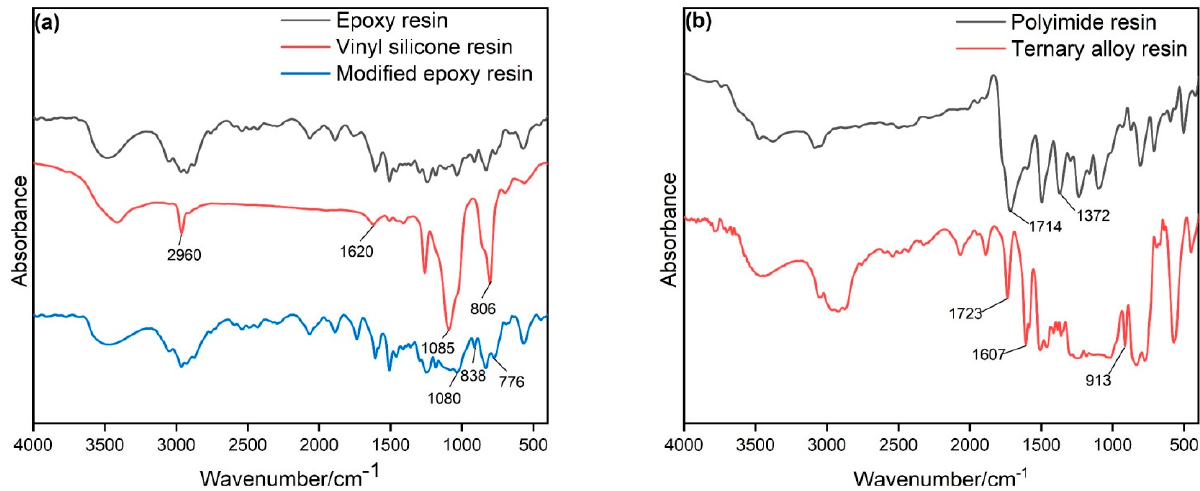
Figure 1. FT-IR spectrogram of different resins: ( a ) Modified epoxy resin (30% of silicone resin), ( b ) Ternary resin (5% of polyimide resin).